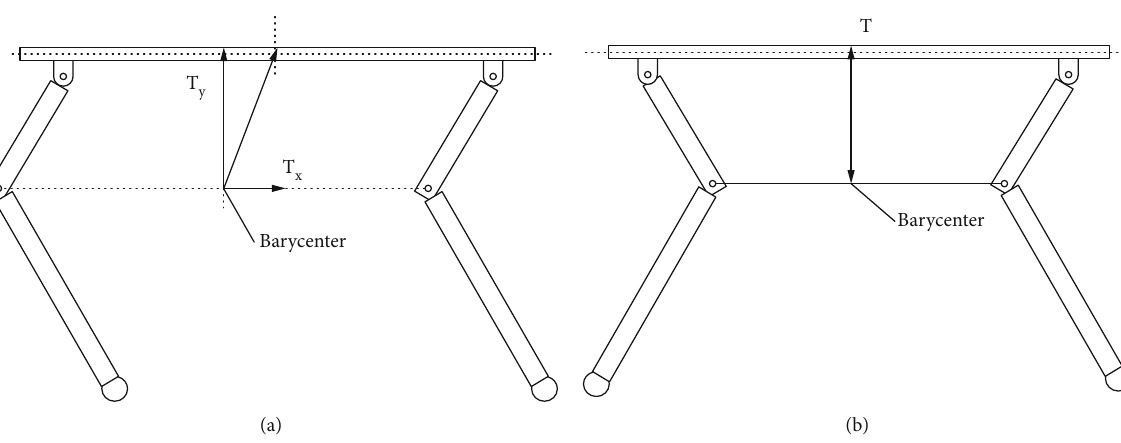
Figure 12: Movement of quadruped robots with elbow joint for front legs and knee joint for back legs under lateral impact.